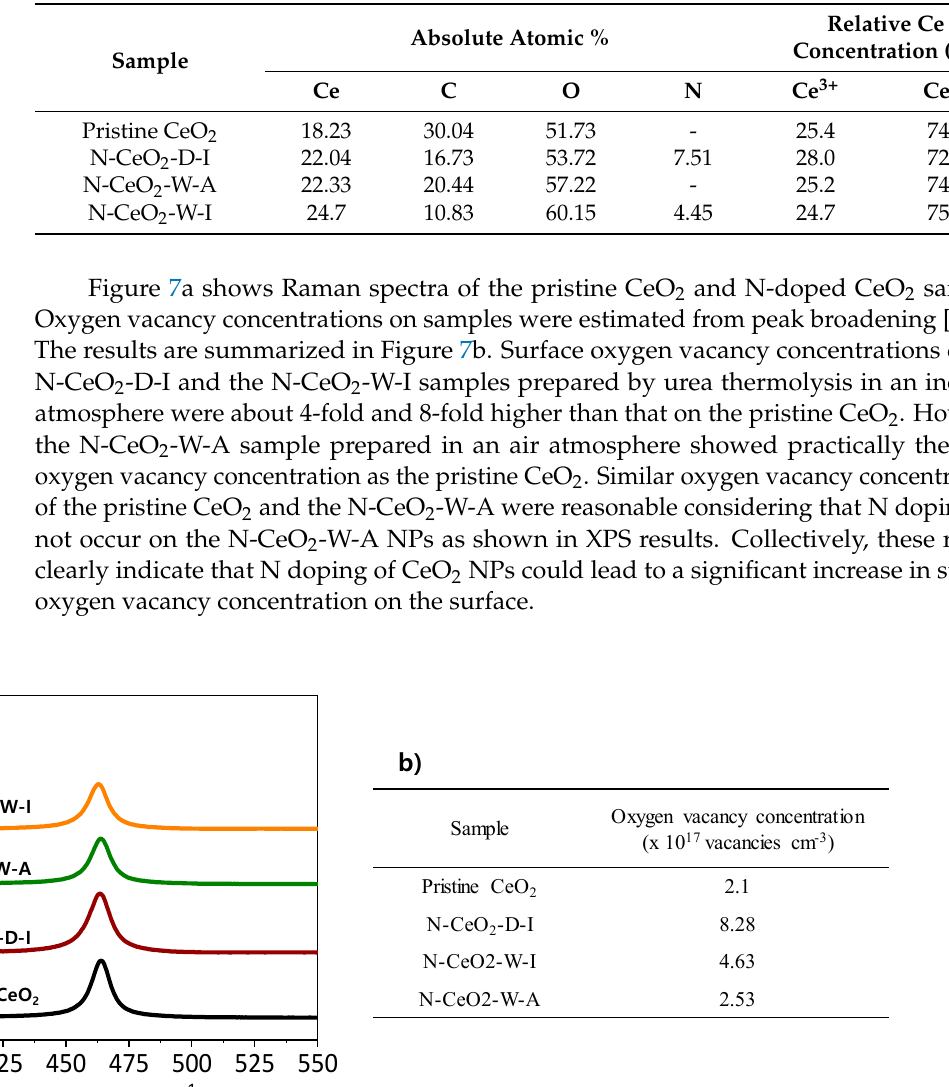
Table 4. Atomic content and the relative Ce concentration on the pristine CeO 2 and the N-doped CeO 2 NPs.